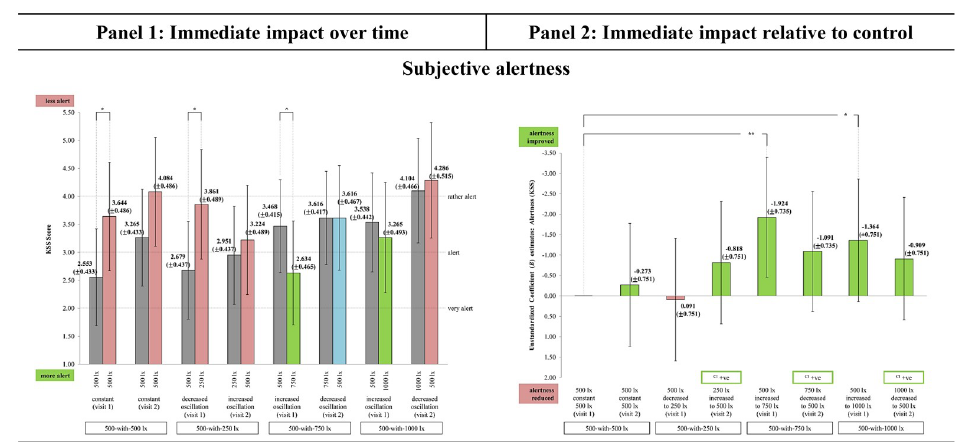
Fig 6. The immediate impact observed in Subjective alertness across the light-settings. (Panel 1) Immediate change over time in all light-settings: Bars represent Estimated Marginal Means (EMM) with Standard Errors (SE); whiskers 95% confidence interval (CI); ��� p < 0.001, �� p < 0.01, � p < 0.05, ^ p < 0.06. Dark grey bar specifies EMM at TP 1 . Green bar specifies EMM at